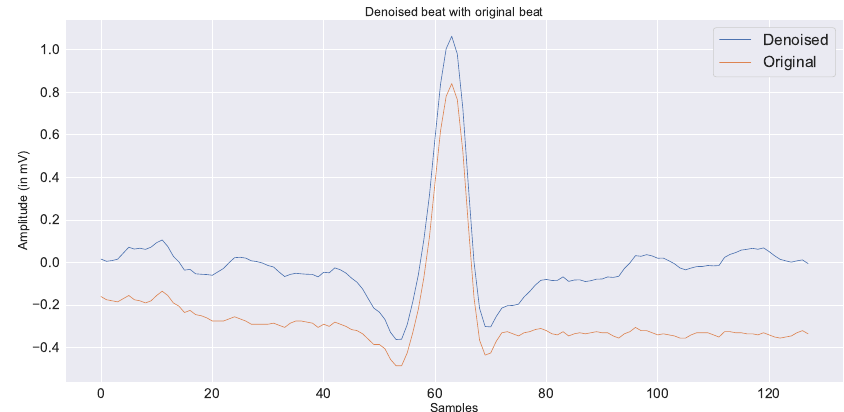
Figure 2. Baseline-wander noise-free beat with an original